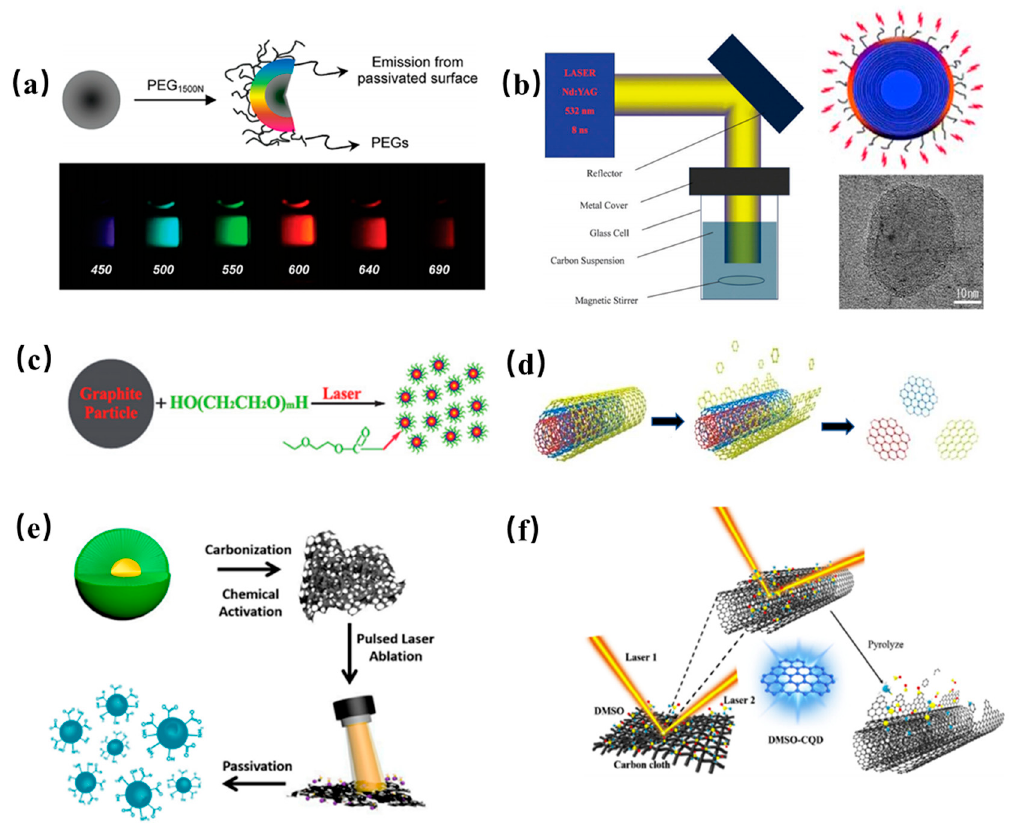
Figure 3. Schematic diagram of ( a ) Fabrication of GQDs by the laser ablation of graphite [6]. Copyright 2006, American